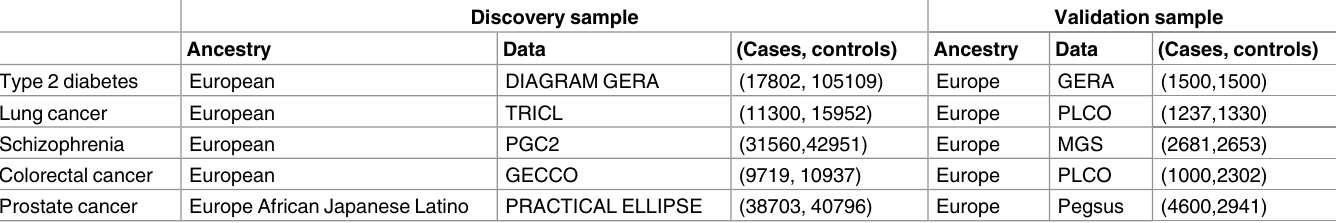
Table 2. GWAS data with summarylevel